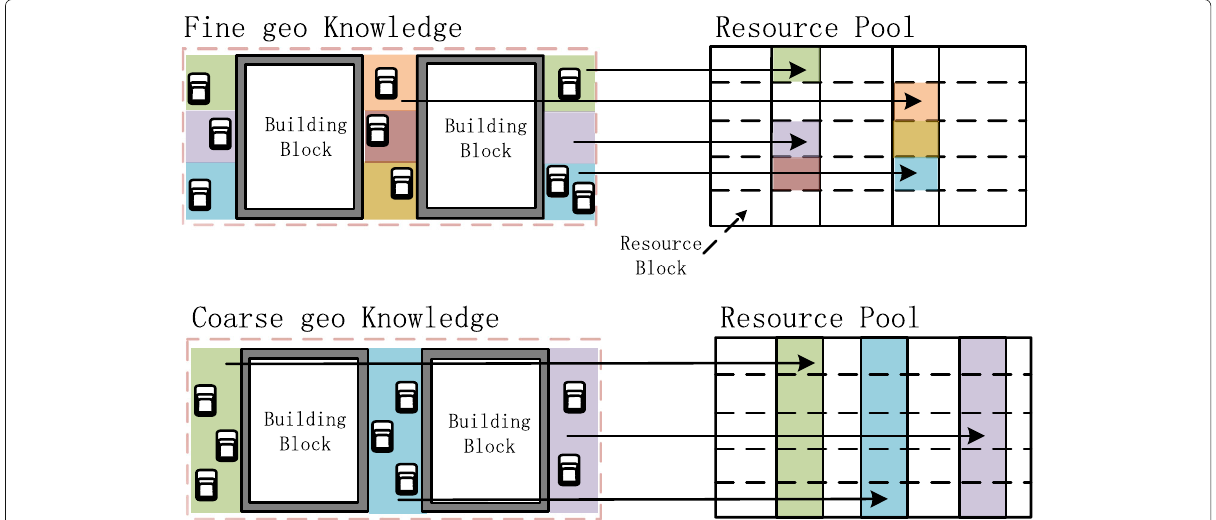
Fig. 5 Geo-based resource selection algorithm. Figure 5 describes the main idea of geo-based resource selection algorithm including fine geo knowledge selection algorithm and coarse geo knowledge selection algorithm. Arrays in this figure represent mapping relationships between geographic areas and resource